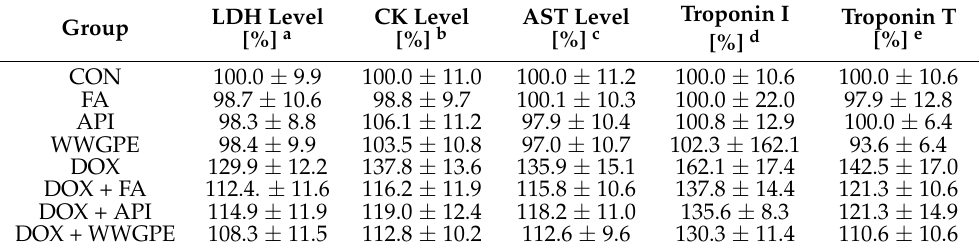
Table 7. Effects of wheat polyphenols (polyphenolic extract of whole wheat grains—WWGPE; ferulic acid—FA; apigenin—API) on changes in biochemical parameters such as cardiotoxicity biomarkers induced by DOX in rat model [65].